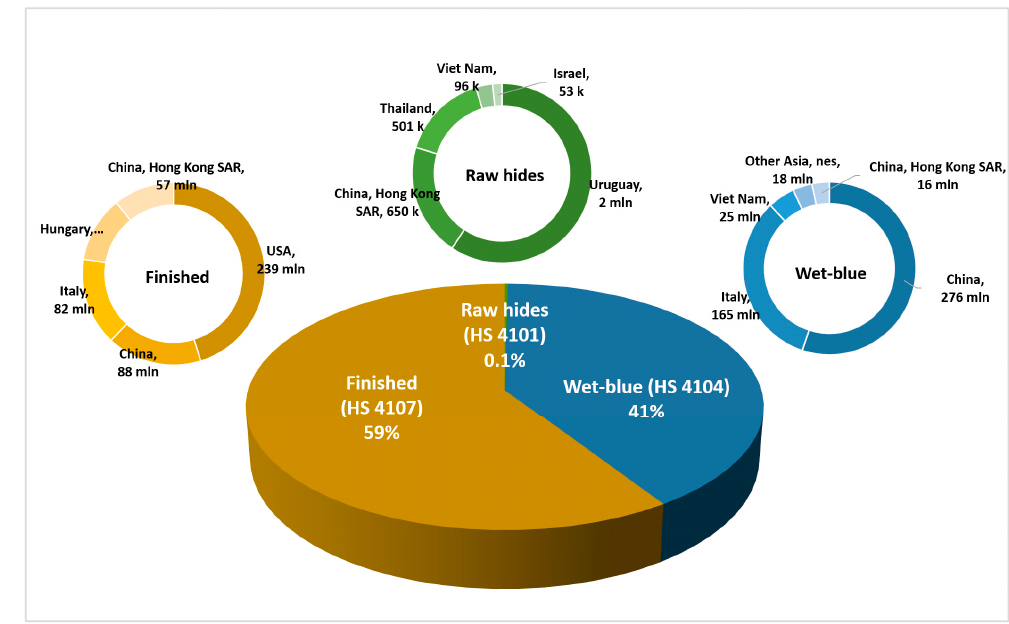
Figure 3. The share of raw (salted) hides, wet-blue and finished leather exported by Brazil in 2018 and the top 5 importers of each HS product category in 2018, in USD [25].